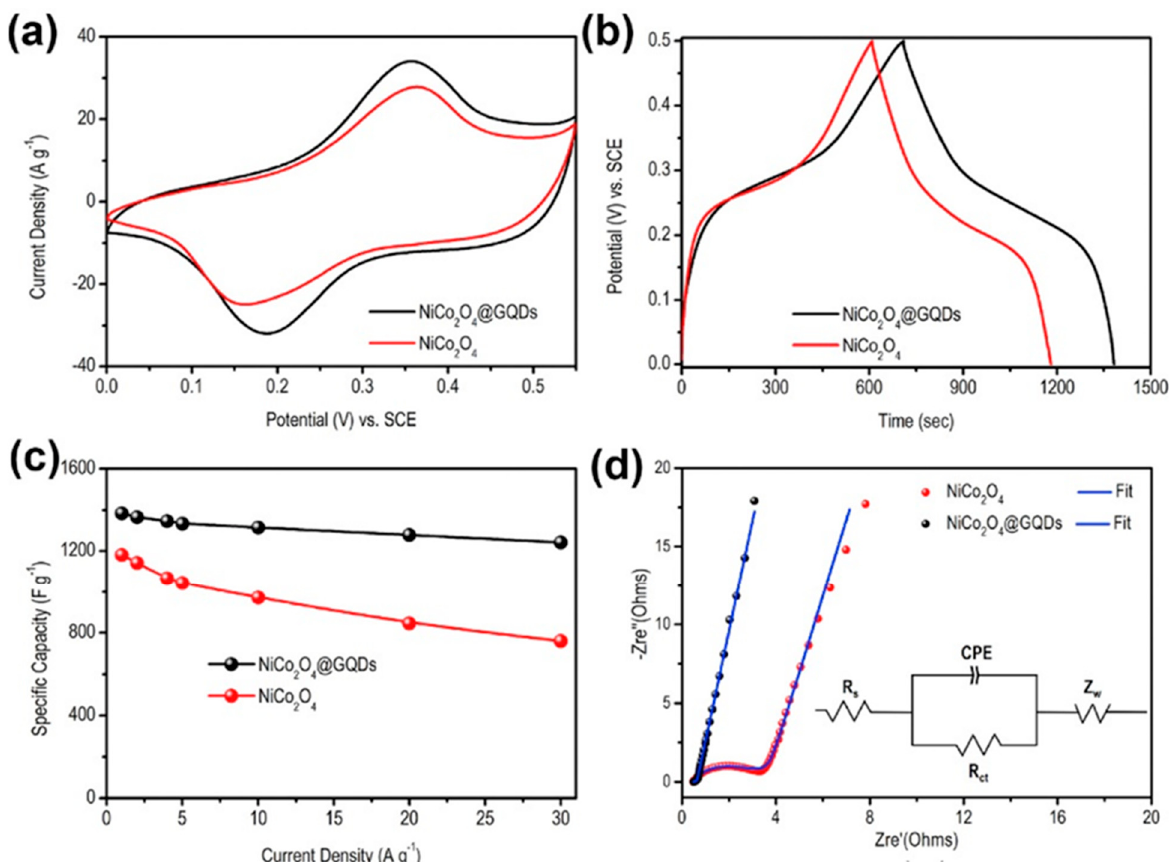
Figure 12. Electrochemical characterizations of the electrodes. ( a ) Cyclic voltammetry (CV) plot. ( b ) Galvanostatic charge-discharge (GCD) plots at 1 A g − 1 current density. ( c ) Variations in specific capacitances at different current densities. ( d ) Fitted Nyquist plots along with the equivalent circuit diagram in the inset. Reprinted with permission from Ref. [107].